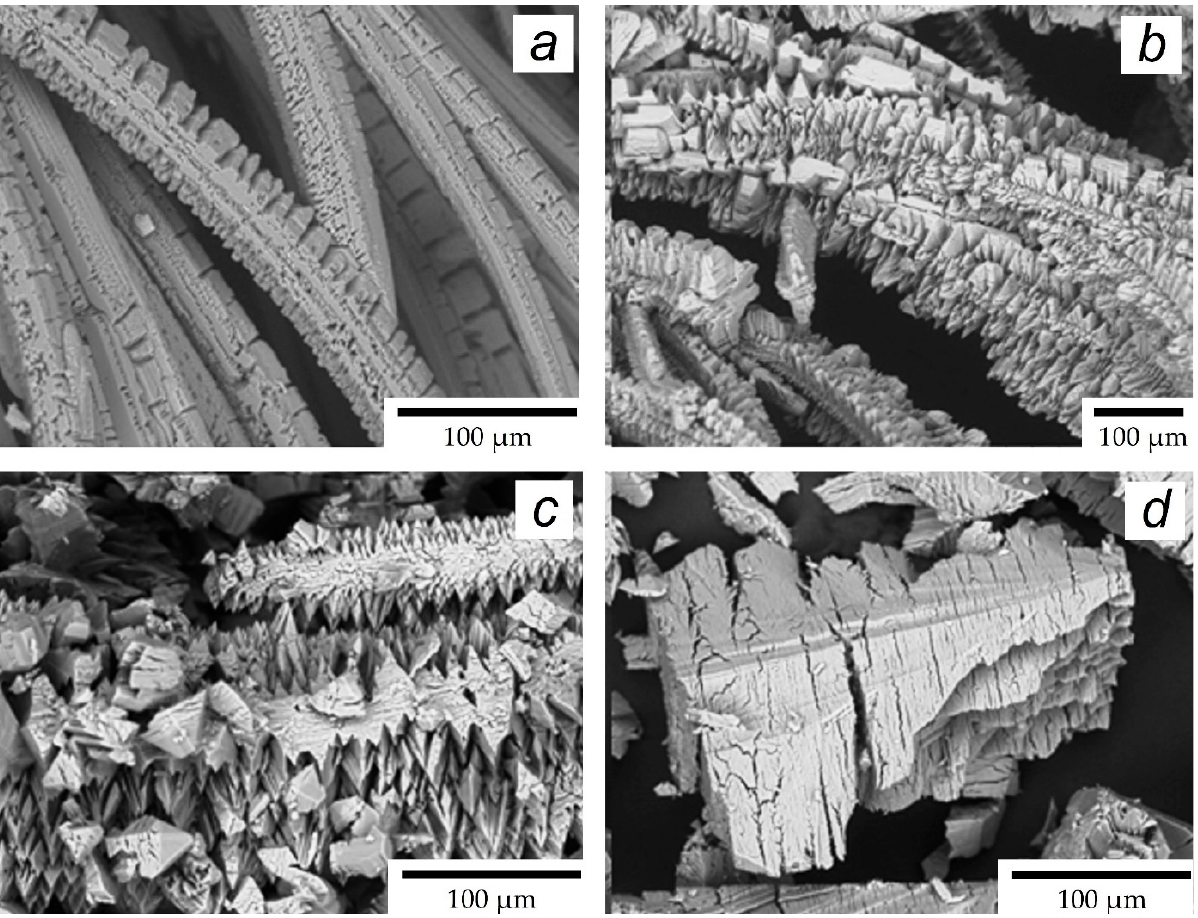
Figure 3. SEM images of calcium sulfate crystals, isolated from Ia ( a ), IIa ( b ), IIIa ( c ) and IVa ( d ) samples of experiments, performed in the presence of 10 mg·dm − 3 PAA-F1.